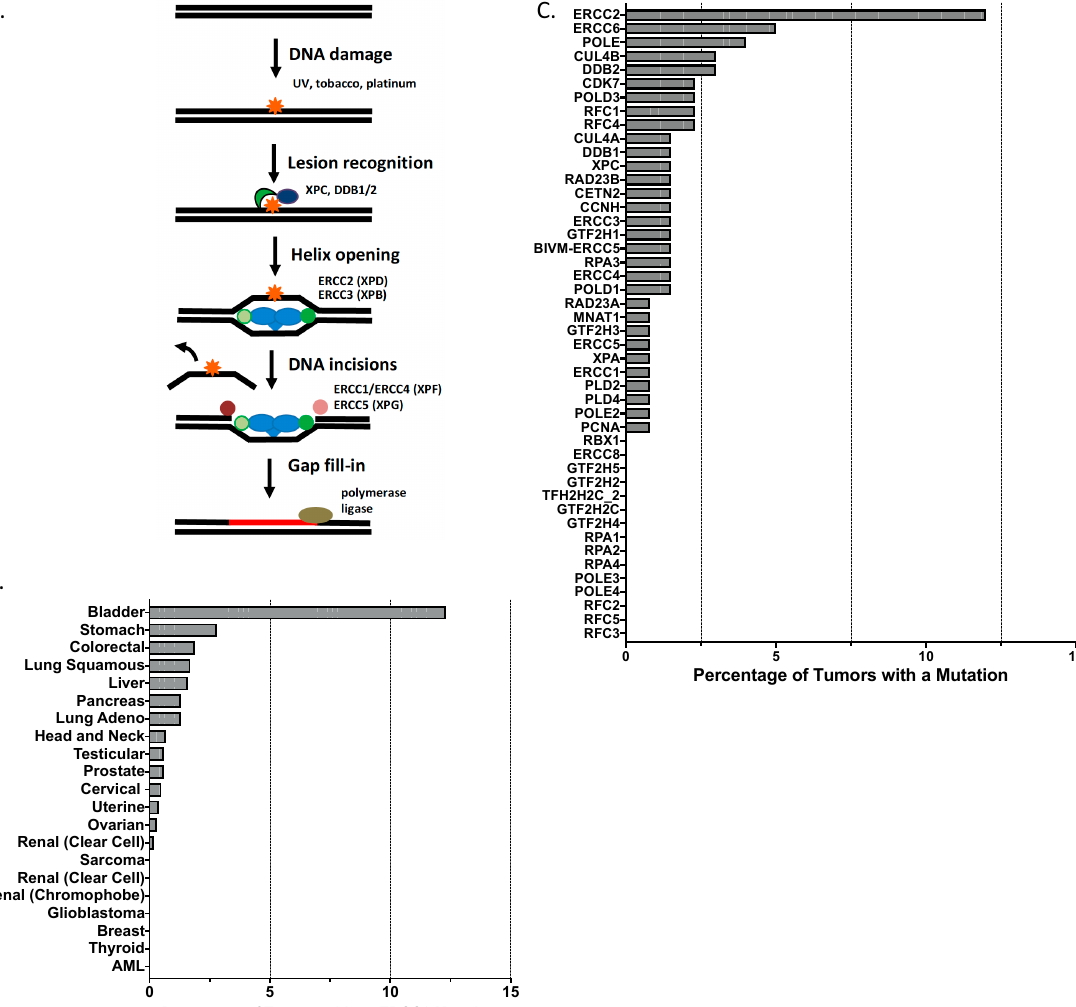
Figure 1. Nucleotide excision repair (NER) pathway mutations in bladder cancer and other tumor types. ( A ) Schematic overview of the NER pathway with select genes of interest highlighted. ( B ) ERCC2 somatic mutation frequency across published or provisional TCGA tumor cohorts. ( C ) Frequency of somatic missense mutations in NER pathway genes in TCGA bladder cohort.